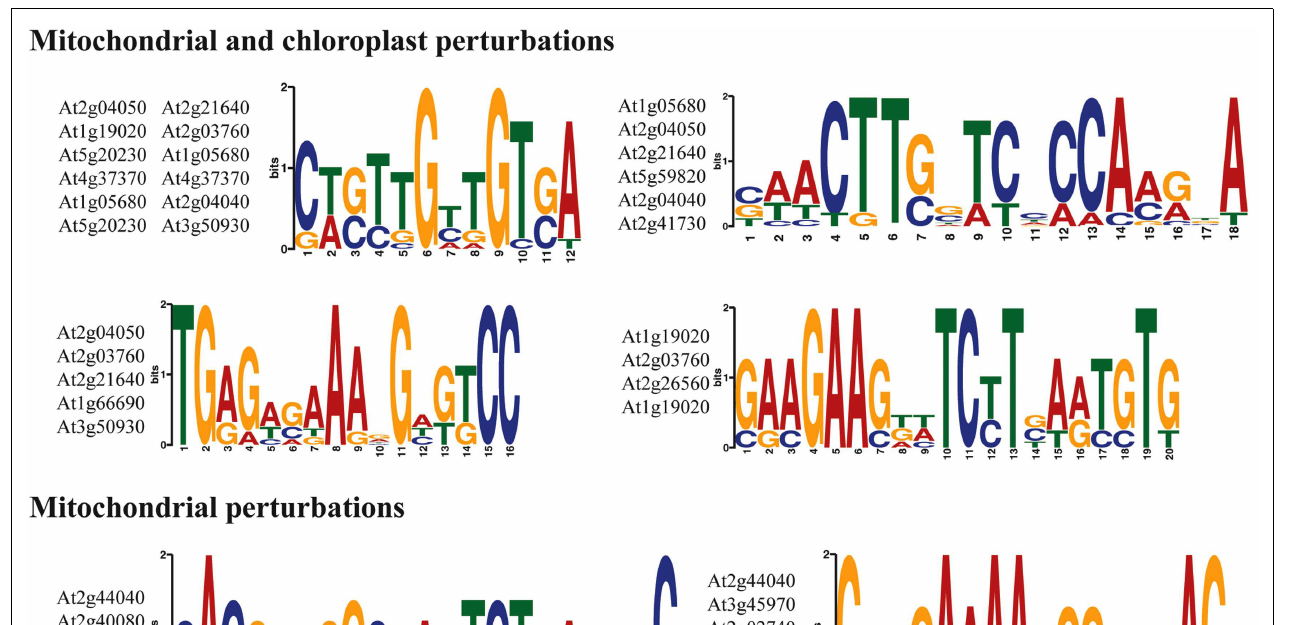
its transcript At1g21760 also responds in six mitochondrial but none of the chloroplast perturbations, making it a good marker gene as well ( Figure 3 ). The Whirly proteins bind ssDNA to pro- mote accurate repair of DNA double-strand breaks